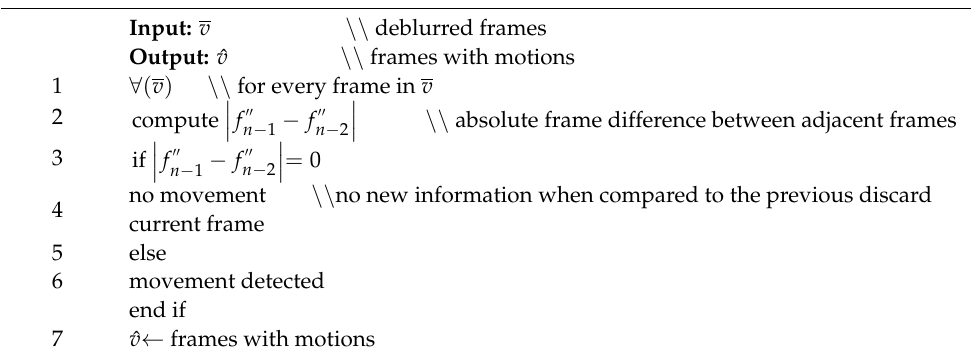
Algorithm 3: Identification Of The First Frame With